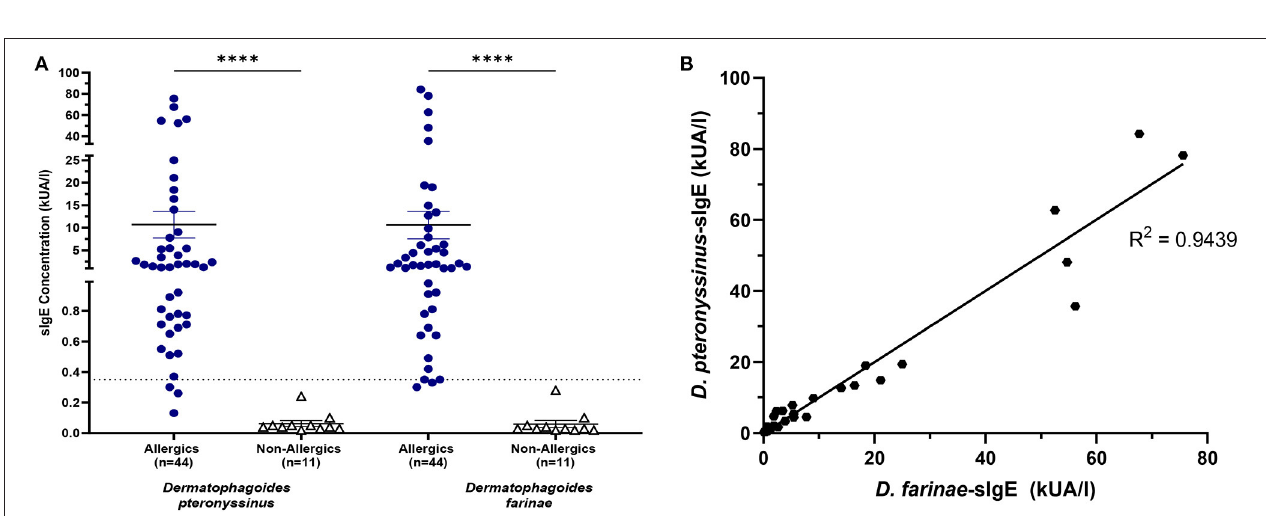
FIGURE 7 | HDM-specific IgE concentrations were significantly increased for allergics. Allergics had significantly elevated Dermatophagoides pteronyssinus- and Dermatophagoides farinae -sIgE compared to non-allergics (A) . Concentrations of D. pteronyssinus- and D. farinae -sIgE were strongly correlation (B) . ****, p < 0.0001.